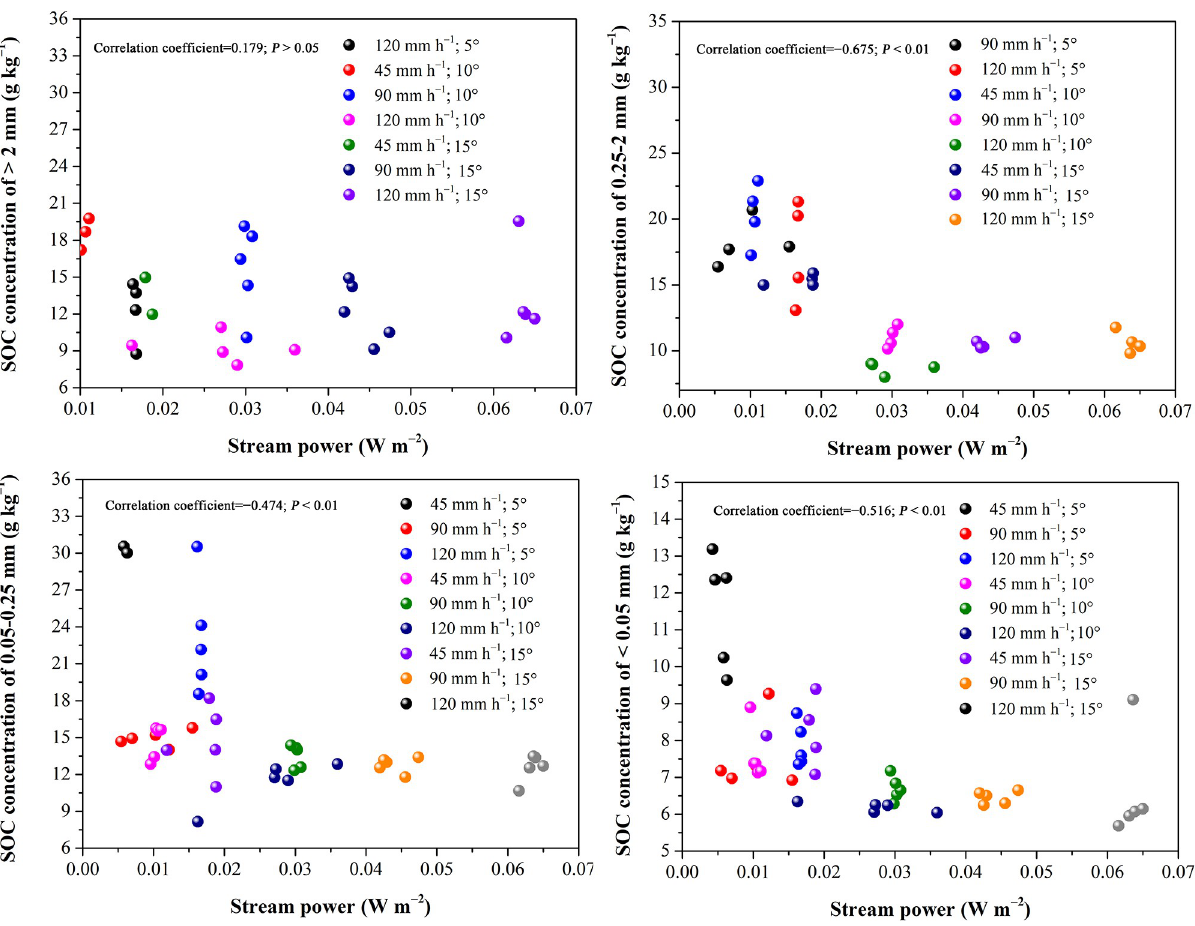
Fig 6. The effect of stream power on the SOC concentration of all size class sediment particles.